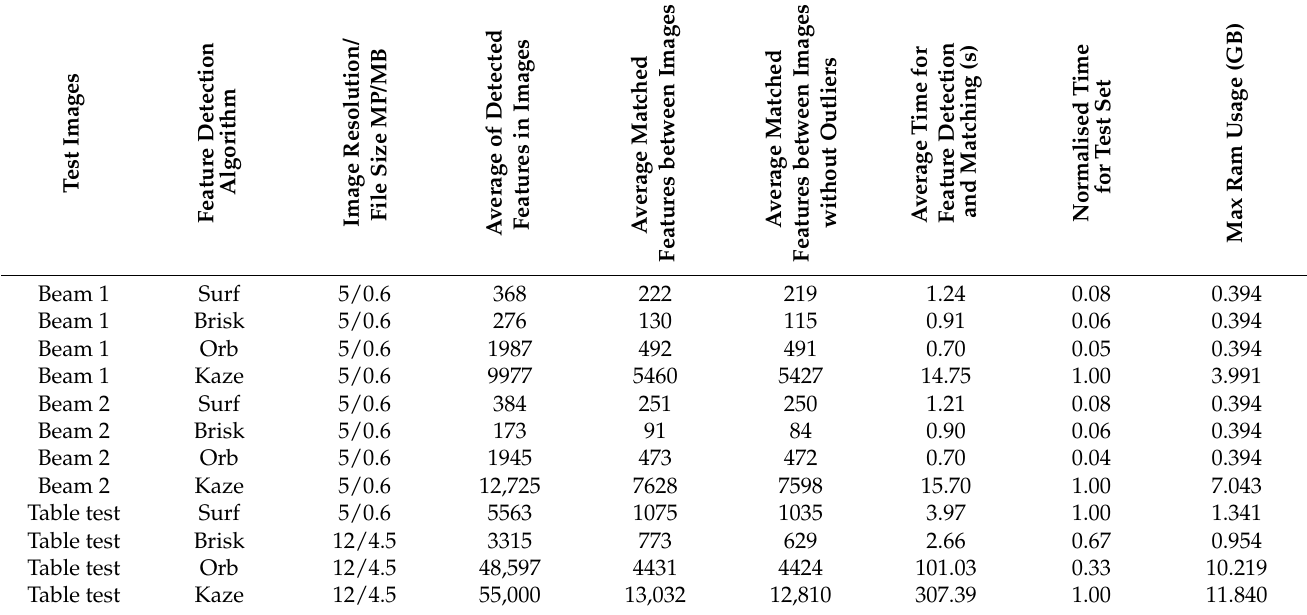
Table 4. Normalized time was calculated for each test image by dividing all the duration times with the longest duration. Normalized time provides a simpler and more intuitive way of comparing duration than comparing times in seconds. Calculated statistical parameters of displacement showed no statistically significant difference. For significance testing, a two-sample t -test was used with a 5% significance level.